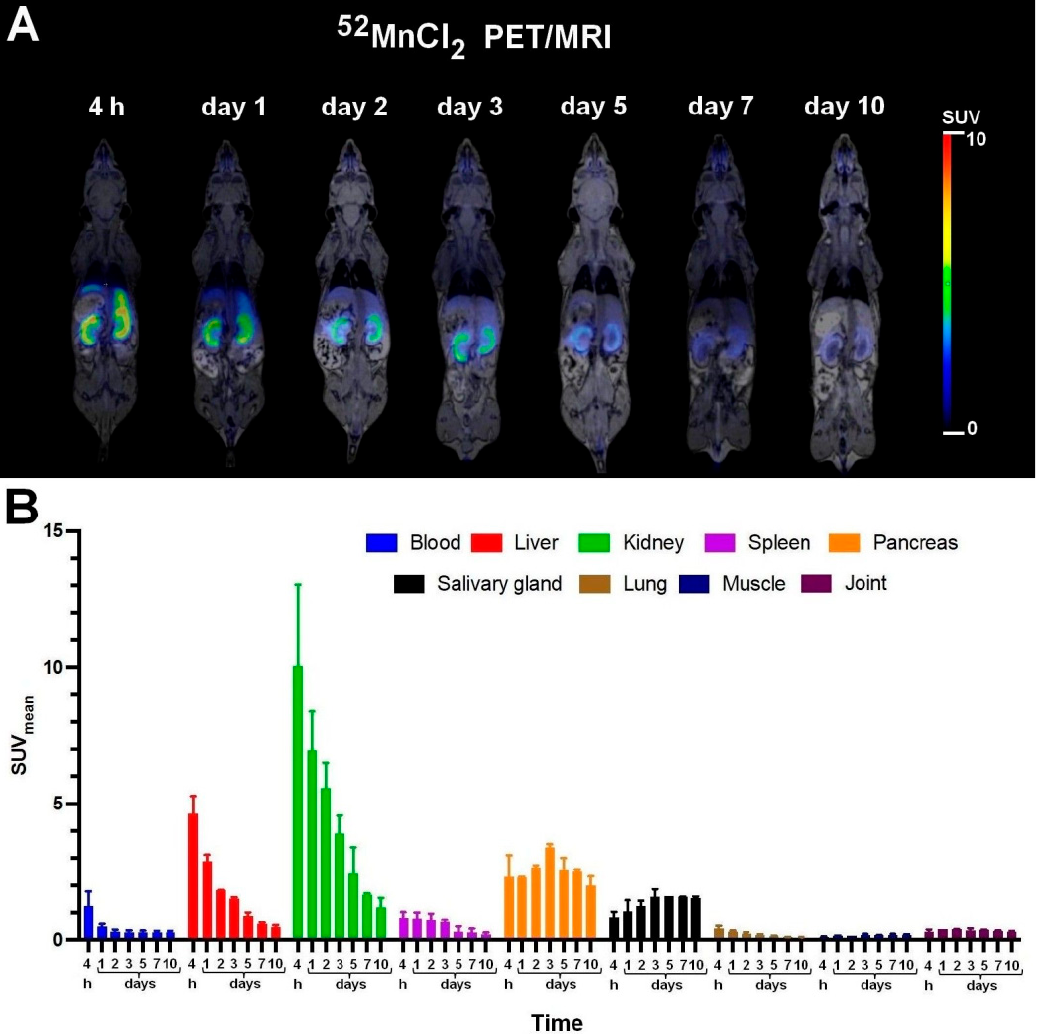
Figure 3. In vivo PET/MRI imaging of 52 MnCl 2 biodistribution ( A ) and average time-activity changes ( B ) of the selected organs 4 h, 1, 2, 3, 5, 7, and 10 days after the intravenous injection of approximately 10 MBq of 52 MnCl 2 . SUV: standardized uptake value. Data are shown as mean ± SD and obtained from n = 5 animals.